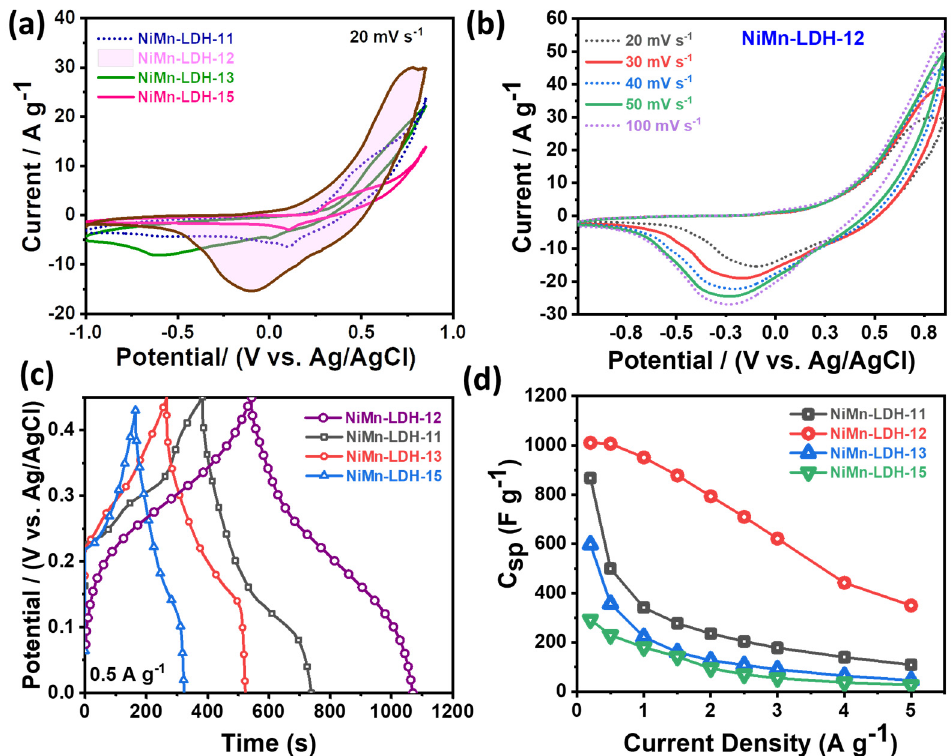
Figure 4. ( a ) CV profile of NiMn-LDH-12 in comparison to its other compositional counterparts; ( b ) corresponding peak current variation against different scan rates in the range of 20 to 100 mV s − 1 in a fixed potential window of − 1 to 0.85 V; ( c ) Charge discharge curves for NiMn-LDH-11, 12, 13 and 15 at a constant current density of 0.5 A g − 1 . ( d ) comparison of specific capacitance of NiMn-LDHs with different Ni: Mn ratios at different current densities under a potential window of 0 to 0.45 V.